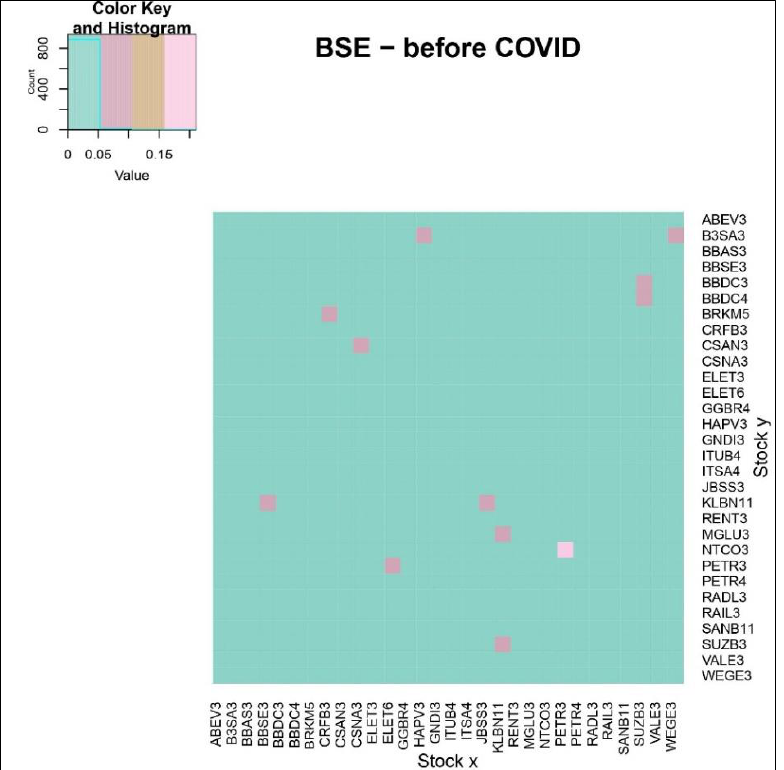
Figure 1. The information flow (effective transfer entropy) from stock y to stock x, for the top companies (by market capitalization) in the BSE market, before the COVID-19 outbreak